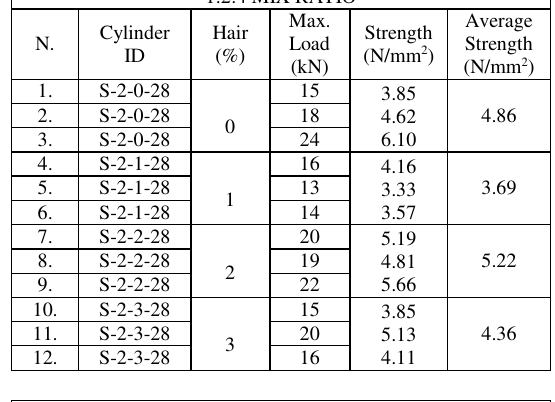
TABLE 4. FLEXURAL STRENGTH TEST RESULTS AT 1:2:4 MIX RATIO